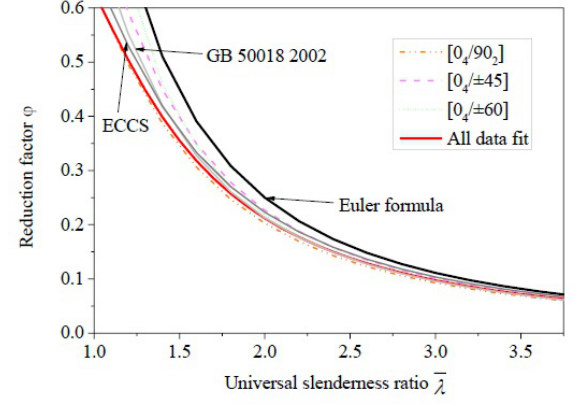
Figure 10: Comparison of the modified Perry fitting curves for three stacking